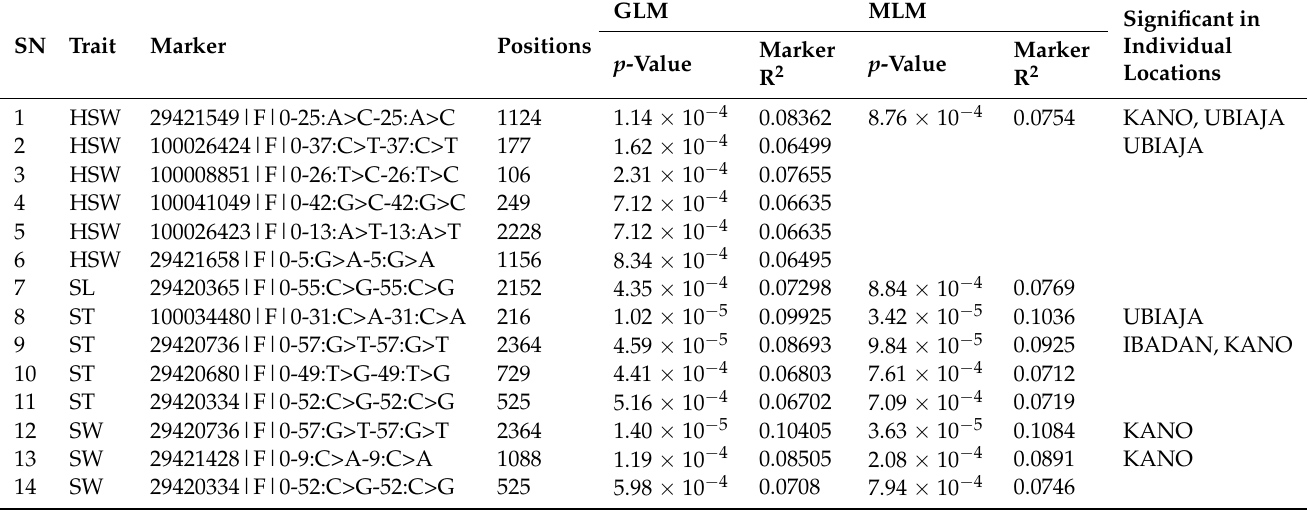
Table 2. DArTseq SNPs markers with significant associations with seed size traits of 195 accessions of African yam bean evaluated during the 2018 and 2019 cropping seasons at three locations in Nigeria (Ibadan, Kano, and